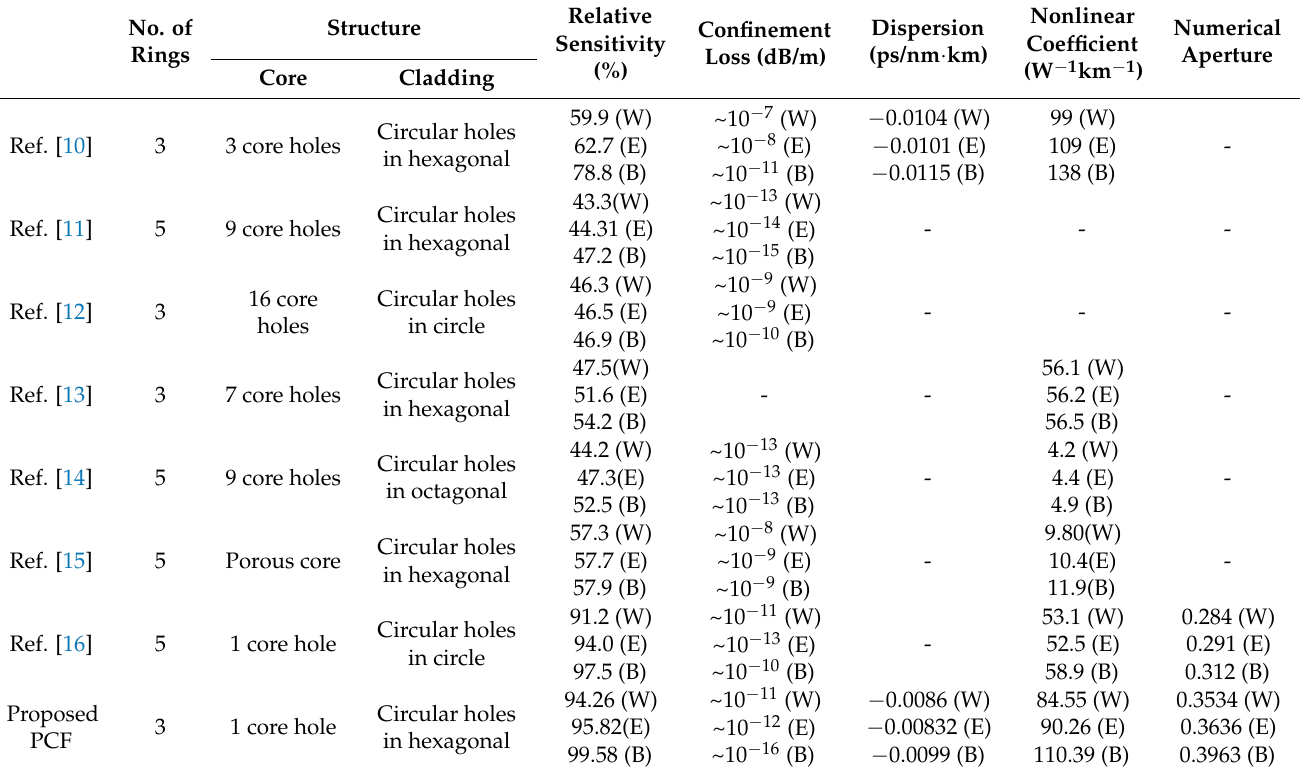
Table 2. Comparison of structure and performance among prior PCFs and proposed PCF at λ = 1.0 µ m. No.